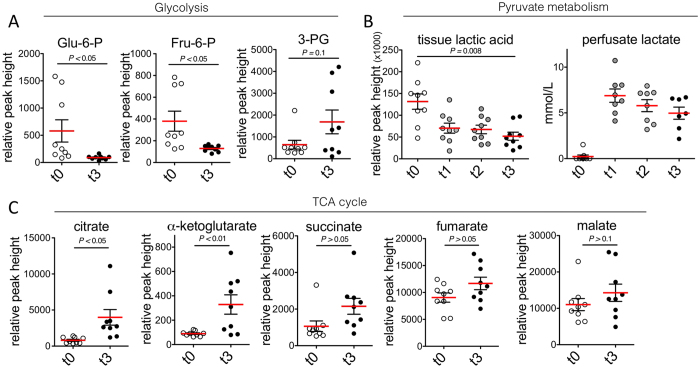
Metabolite changes of key metabolic pathways.(A) Relative values of detected glycolytic intermediates; Glu-6-P, glucose-6-phosphate, Fru-6-P, fructose-6-phosphate; 3-PG, 3-phospoglycerate. Glu-6-P and Fru-6-P decreased significantly during perfusion (P = 0.03, P = 0.015, respectively), while 3-PG showed an insignificant increase (P = 0.09) (B) Relative values of lactic acid in tissue and perfusate concentration of lactate. A large release of lactate was observed in the first hour, after which both tissue lactic acid and perfusate lactate levels decreased significantly (P = 0.004). (C) Relative values of intermediates of the TCA cycle. Significant increases are observed in levels of citrate, α-ketoglutarate and succinate (P < 0.05). Changes in these metabolic pathways represent a reversal of ischemic metabolic shifts and suggest an increase in TCA cycle activity. Bars represent mean ± sem.